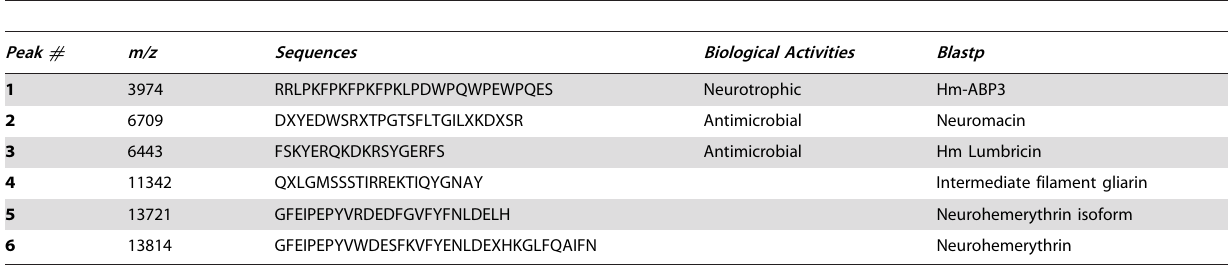
Table 2. Peptide sequences obtained after DD-HPLC, tested in neurite outgrowth or antimicrobial tests and sequenced by automated Edman